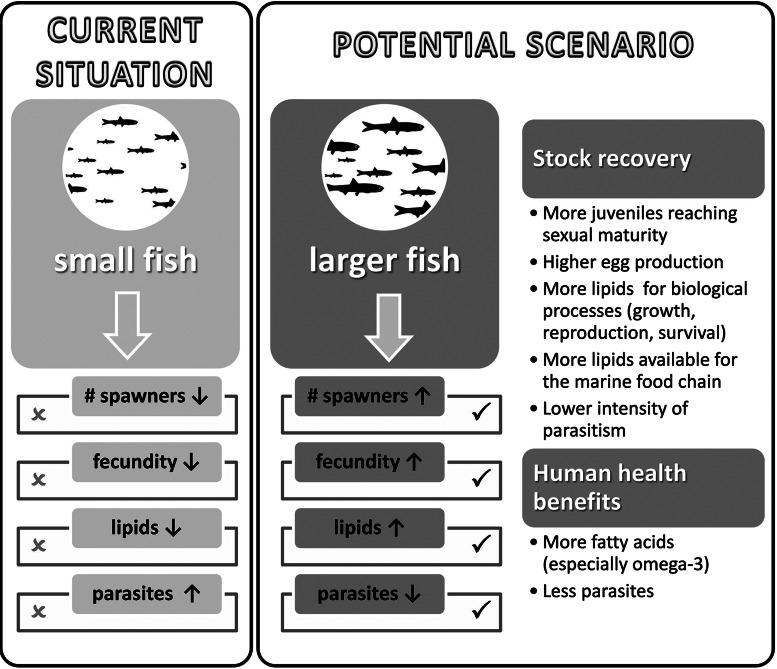
Possible implications for the health of the anchovy stock in a hypothetical scenario in which there is an increase in the median size of anchovy.